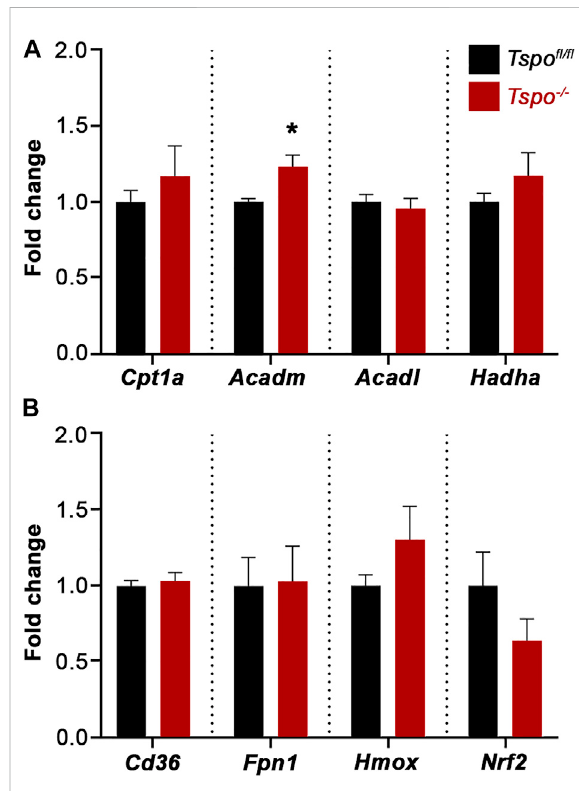
FIGURE 6 Baseline gene expression evaluating regulators of fatty acid oxidation and oxidative stress in Tspo − / − colons. (A) Expression of elements that indicate and/or regulate oxidative stress such as Cd36 , Fpn1 , Hmox , and Nrf2 , showed no difference between Tspo − / − and Tspo fl / fl colons. (B) Expression of Acadm , a mitochondrial enzyme essential to metabolize medium chain fatty acids, was signi fi cantly higher in Tspo − / − colons compared to Tspo fl / fl colons ( p = 0.0425). Expression of other elements associatedwithmitochondrialfattyacid β -oxidationsuchas Cpt1a , Acadl , and Hadha , showed no difference between Tspo − / − and Tspo fl / fl colons. Signi fi cance indicated as * p <